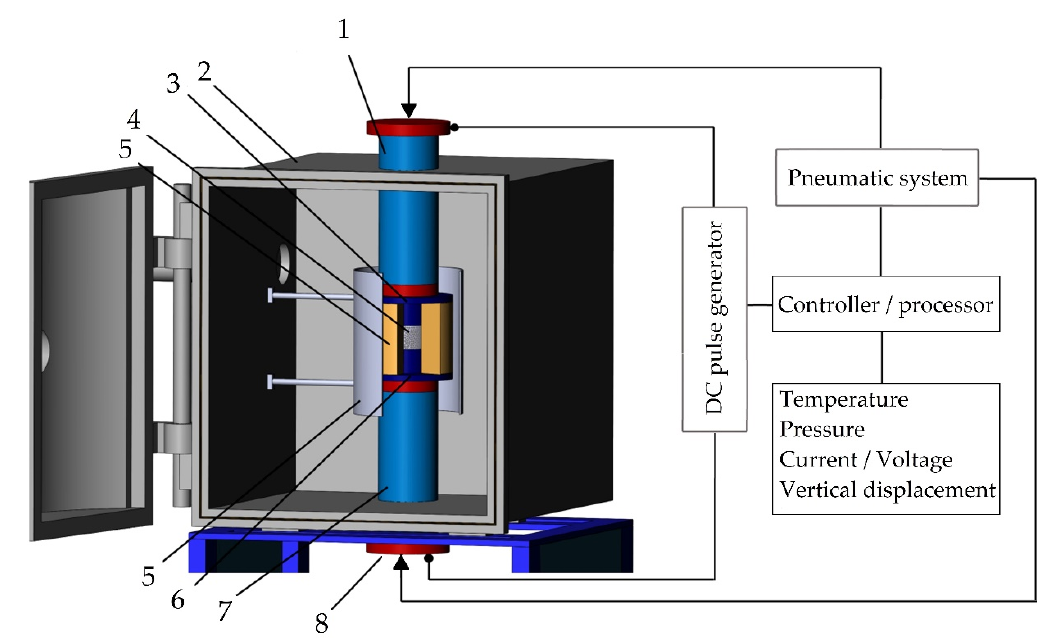
Figure 6. The configuration of the spark plasma sintering system developed in MSTU STANKIN: ( 1 ) is an upper electrode, ( 2 ) is a vacuum chamber, ( 3 ) is an upper punch, ( 4 ) is pressed powder, ( 5 ) is a die block, ( 6 ) is a heater, ( 7 ) is a lower punch, ( 8 ) is a lower electrode.